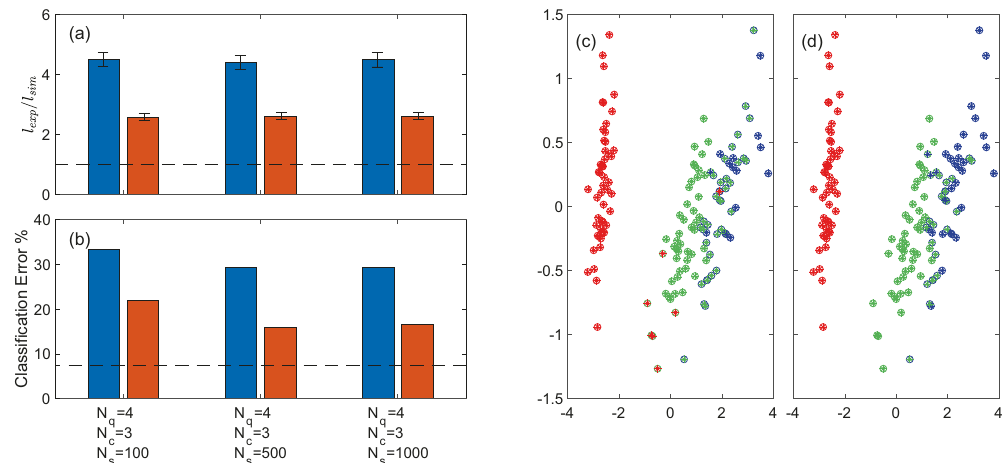
Fig. 10 Iris data set. a Ratio of distance calculated from the quantum computer vs the simulator, and b classi fi cation of Iris data. There were 150 data points in total. The dashed line shows the accuracy of classical nearest centroid algorithm. The error bars in a correspond to the standard error in the ratio of distances for each dataset. Iris data classi fi cation pictured after using principal component analysis to reduce the dimension from 4 to 2. The color of the boundary of the circles indicates the three human-assigned labels. The color of the interior indicates the class assigned by the quantum computer. c shows the classi fi cation before error mitigation using 500 shots, and d shows the classi fi cation